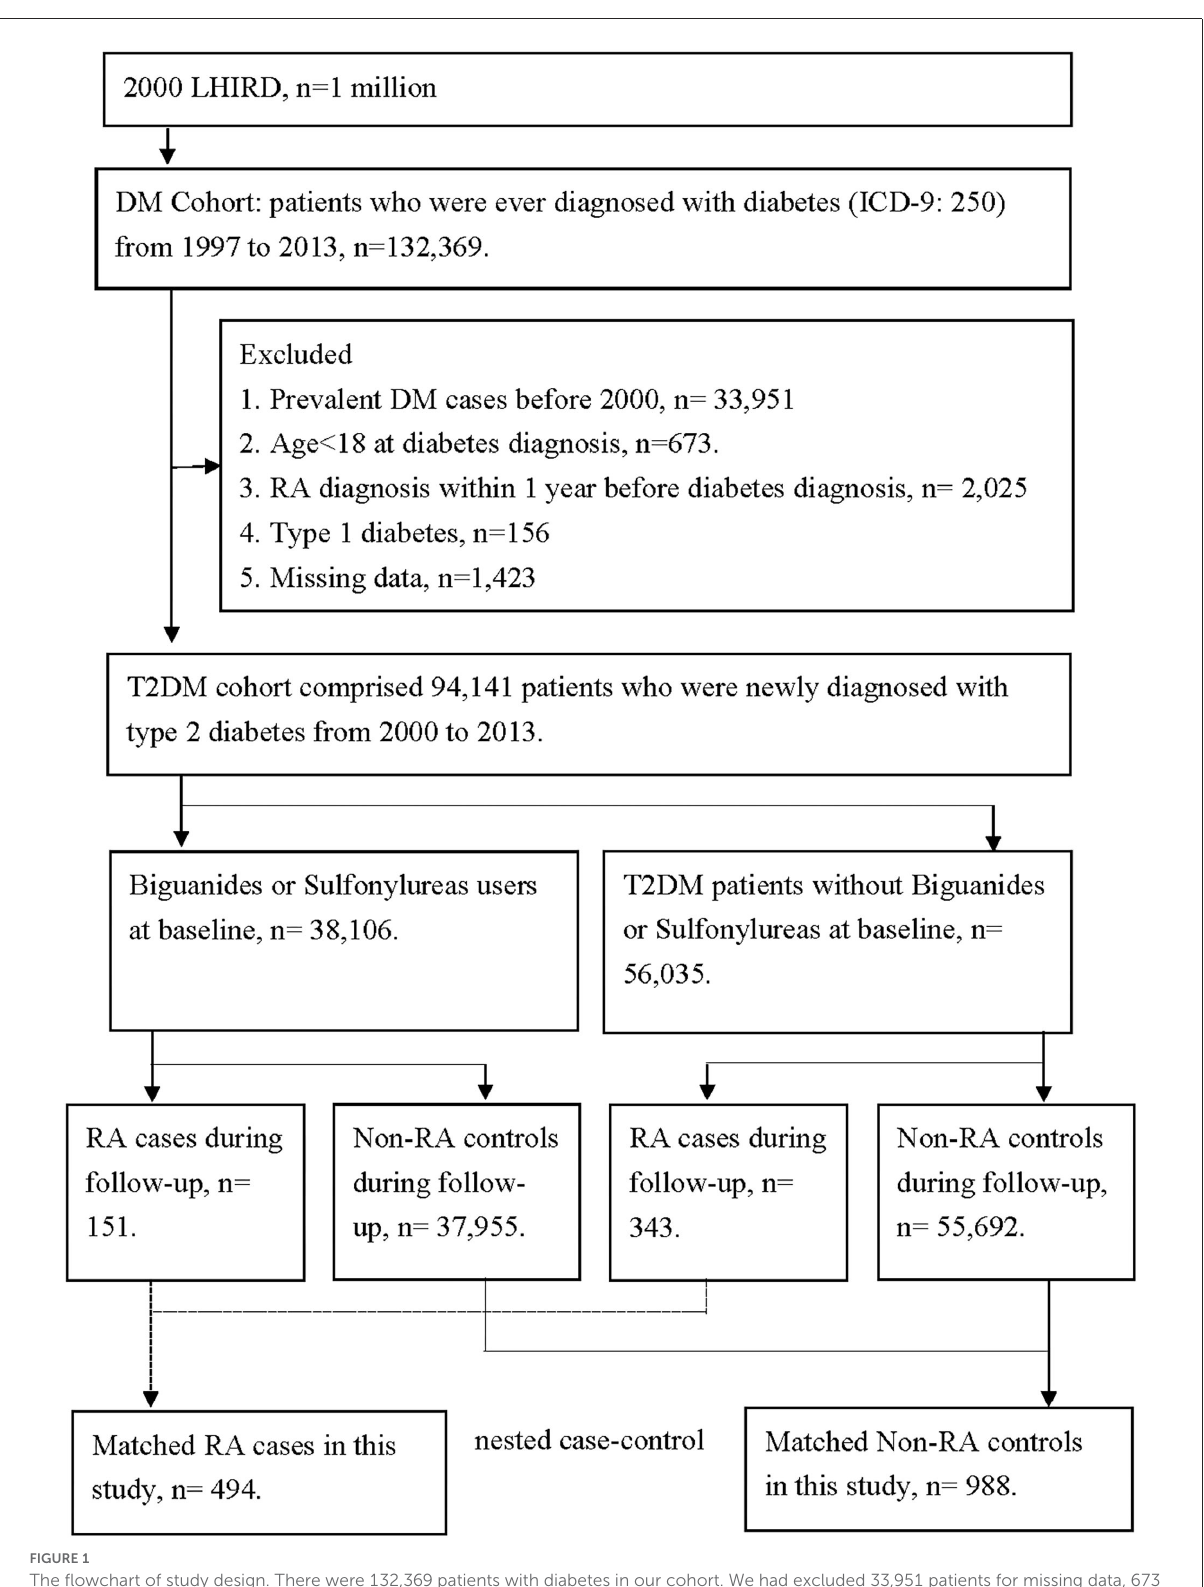
FIGURE1 The flowchart of study design. There were 132,369 patients with diabetes in our cohort. We had excluded 33,951 patients for missing data, 673 patients with age < 18 years, 2,025 patients with previous RA diagnosis, 2,025 patients with type 1 diabetes, and 1,423 patients with missing age or gender data. So, there were 94,141 diabetes patients enrolled in our cohort. According to the comorbidities, 494 patients were diagnosed with RA, and 93,647 patients were not diagnosed with RA. We had further matched age and gender between the RA patients and non-RA patients. Finally, there were 494 RA patients and 988 non-RA patients in our nested case-control study. The comparisons between the two subgroups in the nested case-control analysis were used to demonstrate the cumulative doses of anti-diabetes treatment and their relation to RA incidence